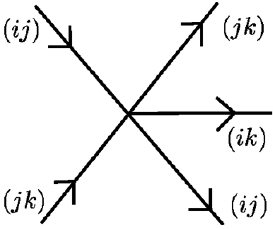
Figure 2. Birth of an ( ik )-trajectory at the intersection of an ( ij )- and a ( jk